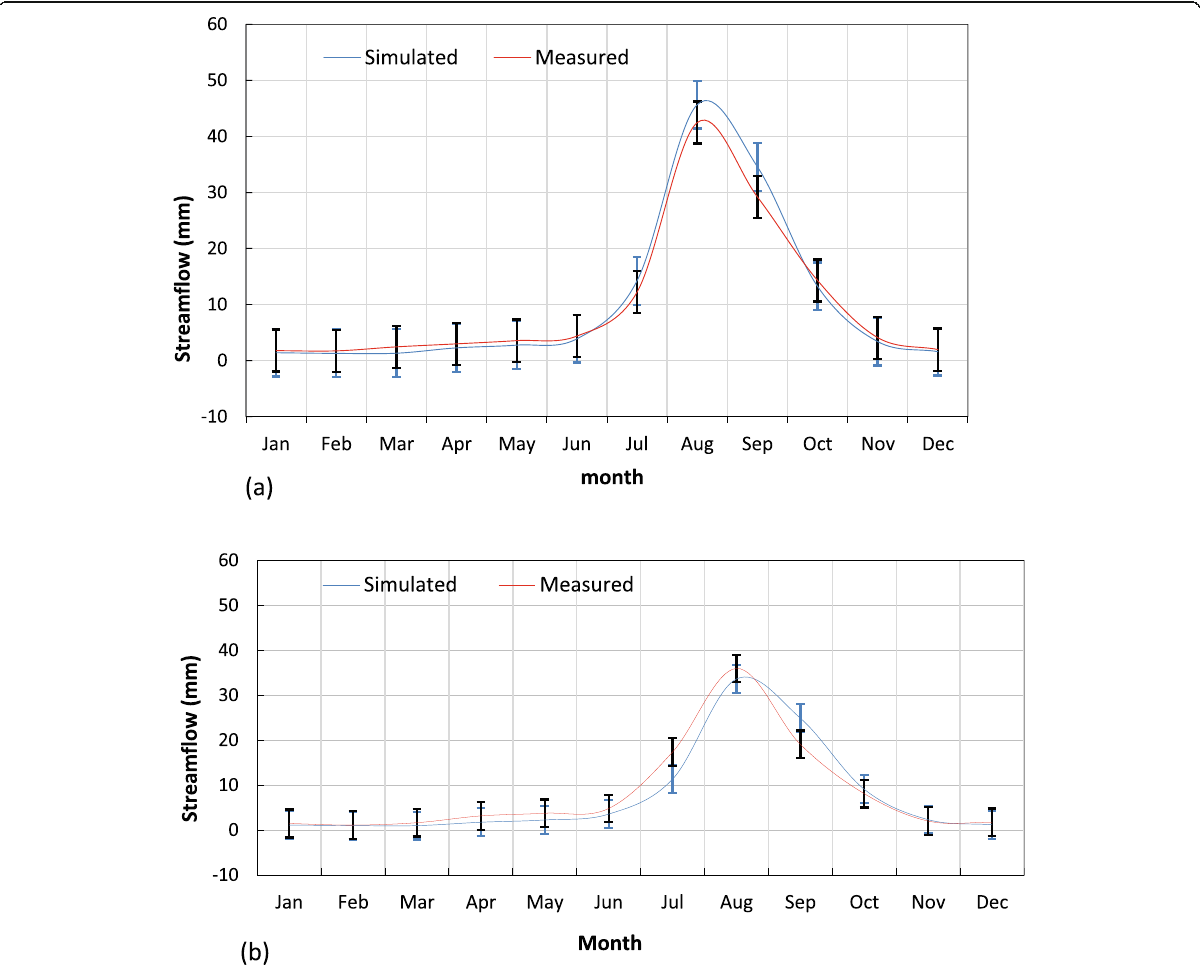
Fig. 7 Mean monthly hydrograph of measured, simulated flows of Ketar River at Abura gauging station for a the calibration and b the validation period; black line and green line error bars indicate the standard error of monthly measured and simulated flows respectively